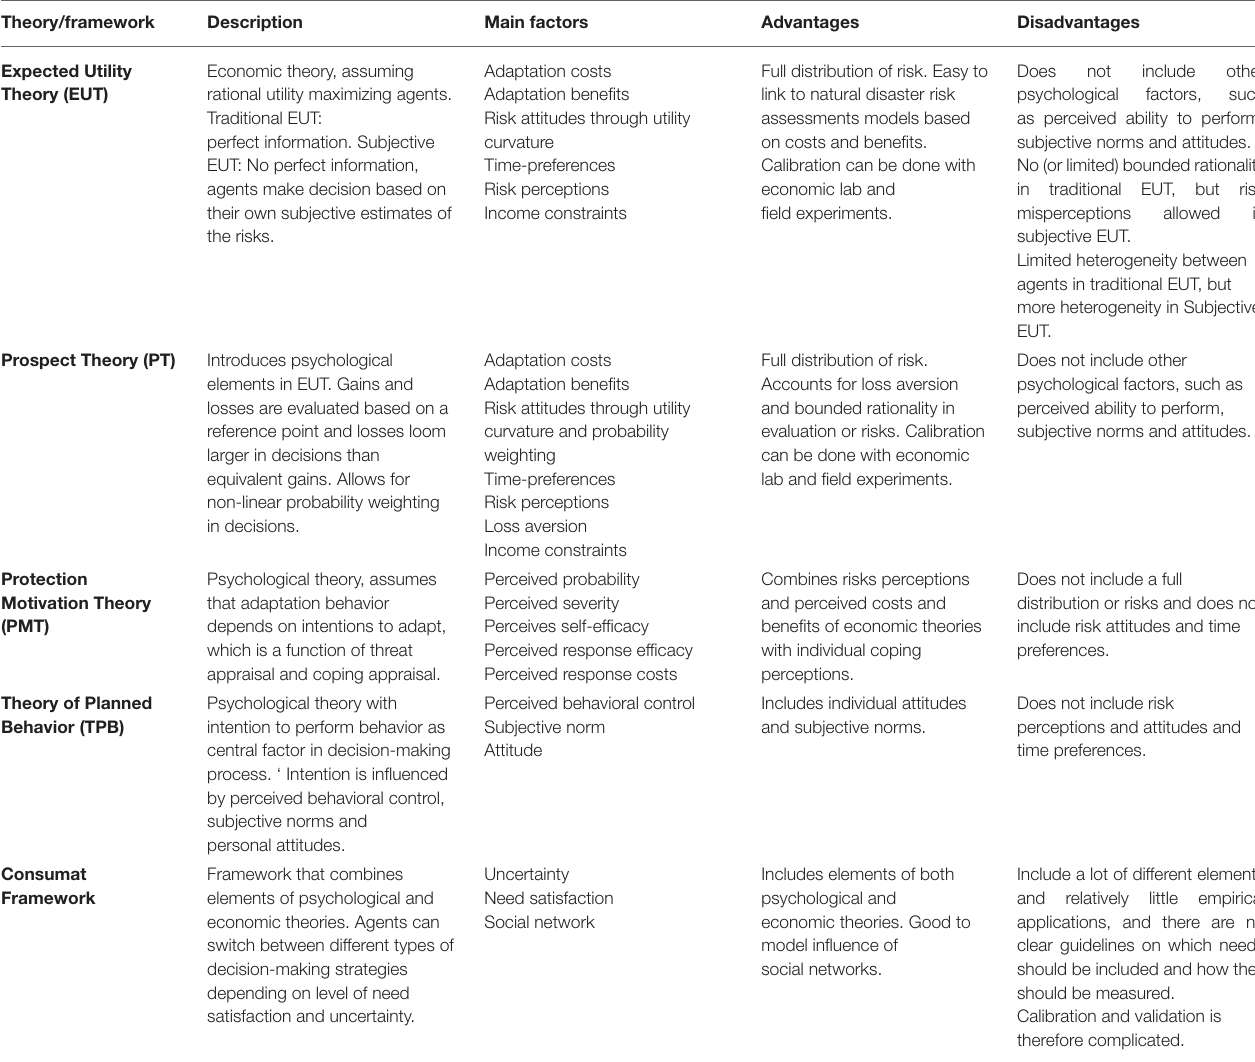
TABLE 2 | Overview of